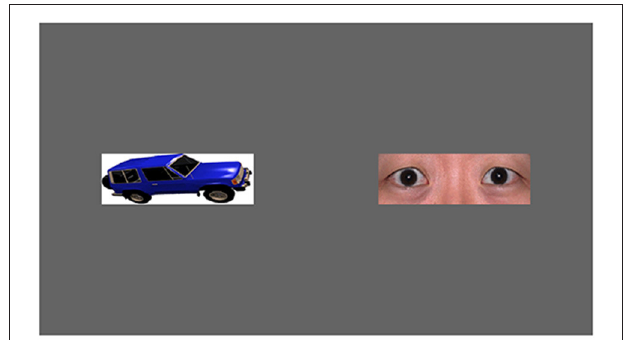
FIGURE 1 | Sample stimuli in the HAI